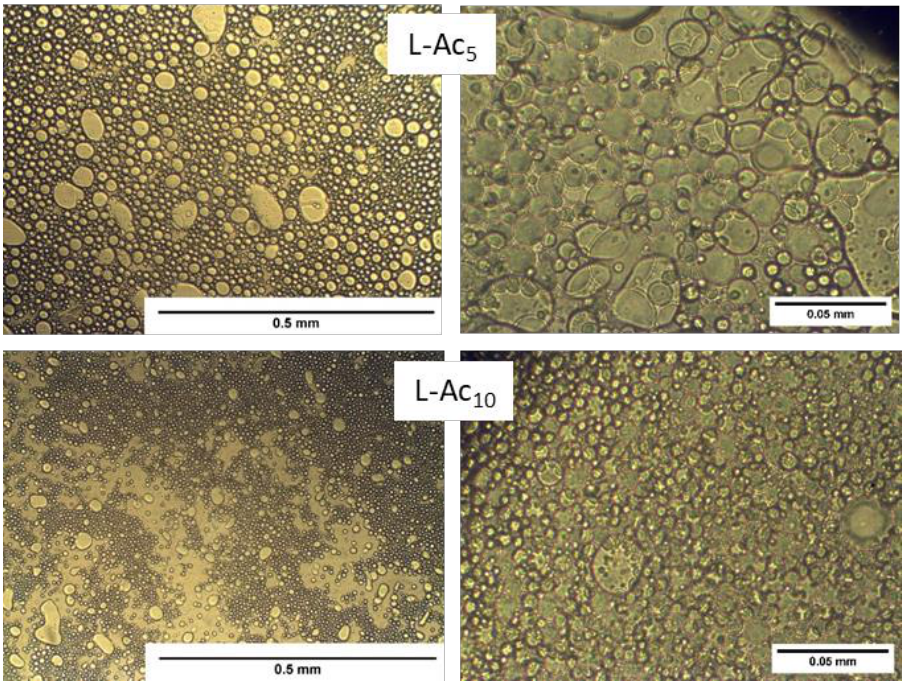
Figure 4. Optical microscopy of water-in-oil emulsions made with the addition of PL extract or liposomal dispersions. ( a ) 10× magnification; ( b ) 40× magnification.